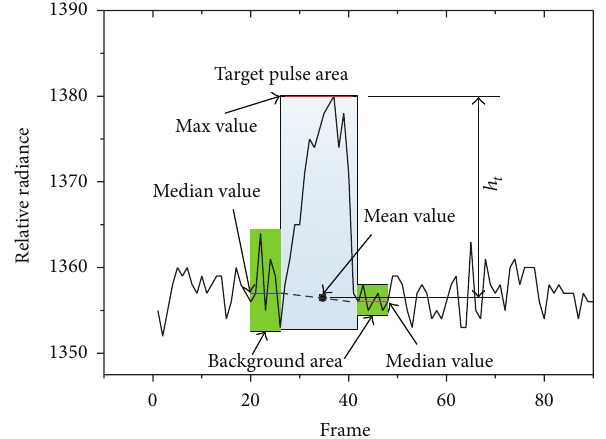
Figure 8: The calculation of target pulse signal extraction.